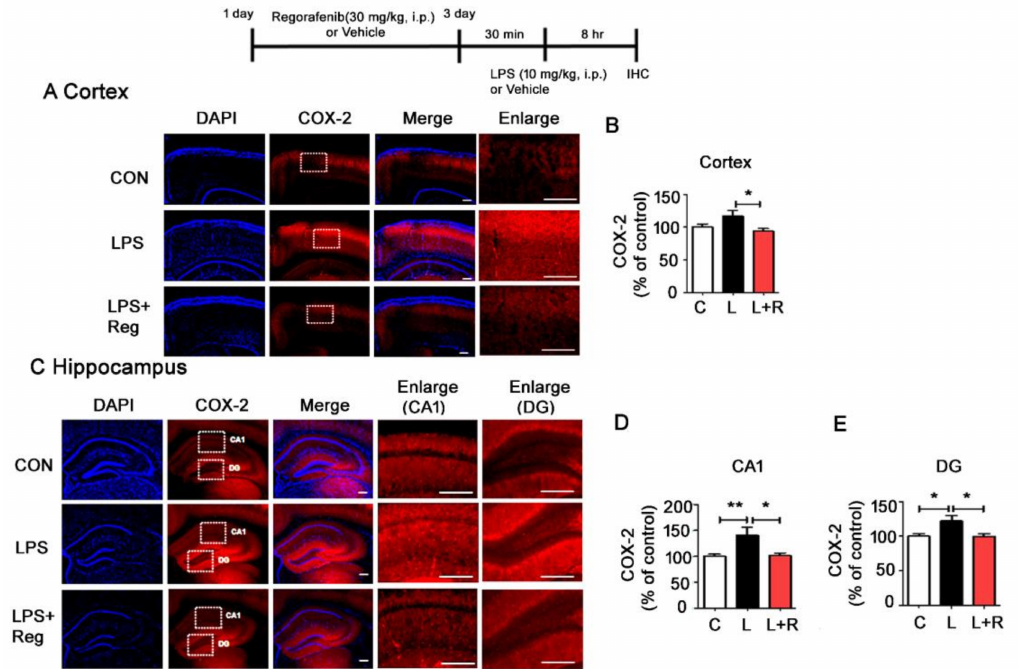
Figure 5. Regorafenib modulates LPS-induced proinflammatory cytokine COX-2 upregulation in vivo. ( A – E ) Wild-type mice were injected with regorafenib (30 mg / kg, i.p.) or vehicle (2% DMSO + 30 % PEG + 5 % Tween 80) daily for three days and subsequently treated with LPS (10 mg / kg, i.p.) or PBS for 8 h. Then, the treated wild-type mice were perfused and fixed, and immunohistochemistry was performed with anti-COX-2 antibody (n = 7 mice / group). * p < 0.05, ** p <